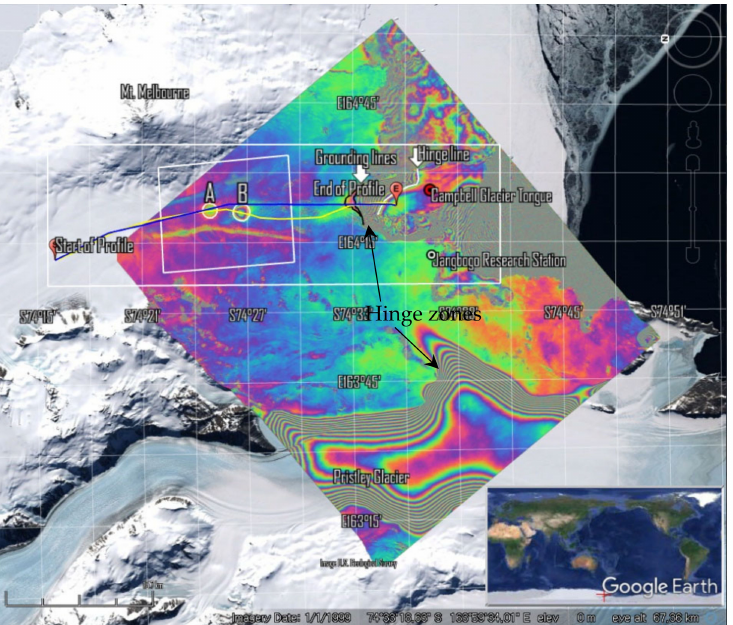
Figure 3. An example of DDInSAR image by subtracting the DInSAR pair [20100616-20100617] from the pair [20110502-20110503], also shown in Figure 4e. A and B are the velocity anomalies found in the central valley along the profile lines. Note that dense fringes are tidal deflection at the hinge zones of Priestly Glacier (bottom) and Campbell Glacier (top). The possible grounding lines and hinge line were drawn in black and white lines near the Campbell Ice